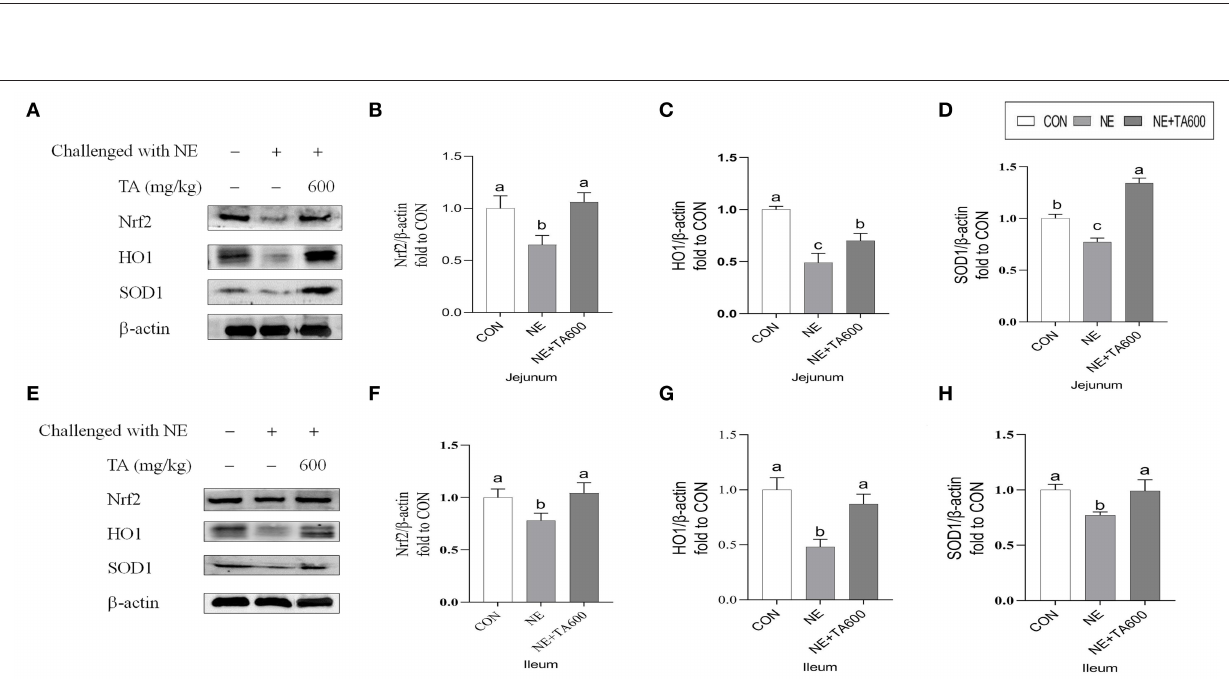
FIGURE 3 | Effects of TA on the mRNA abundance of Nrf2 pathway and antioxidant enzymes in the jejunum and ileum of subclinical NE broilers. Values are means with their standard errors represented by vertical bars. a,b Means within a row with different letters differ significantly ( p < 0.05). Nrf2, nuclear factor erythroid 2-related